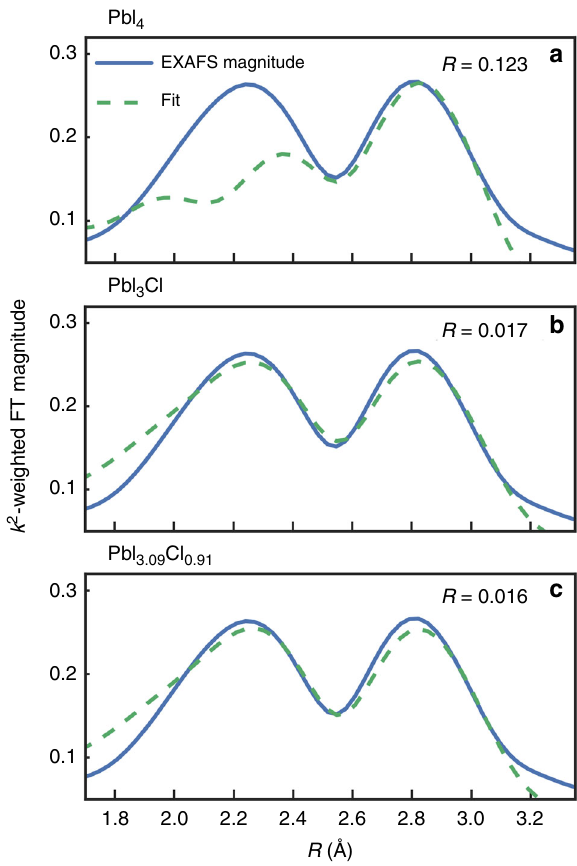
Fig. 2 Pb-L 3 EXAFS of the precursor fi lm. The fourier transform of the k- space EXAFS is plotted, weighted by k 2 . Solid lines are magnitude of the measured EXAFS, dashed lines are the fi t. R represents mis fi t; lower is better. a Fit to I in all sites (equitorial and axial) of the precursor structure. b I in equitorial and Cl in axial sites. c Best fi t has I in equitorial sites and in